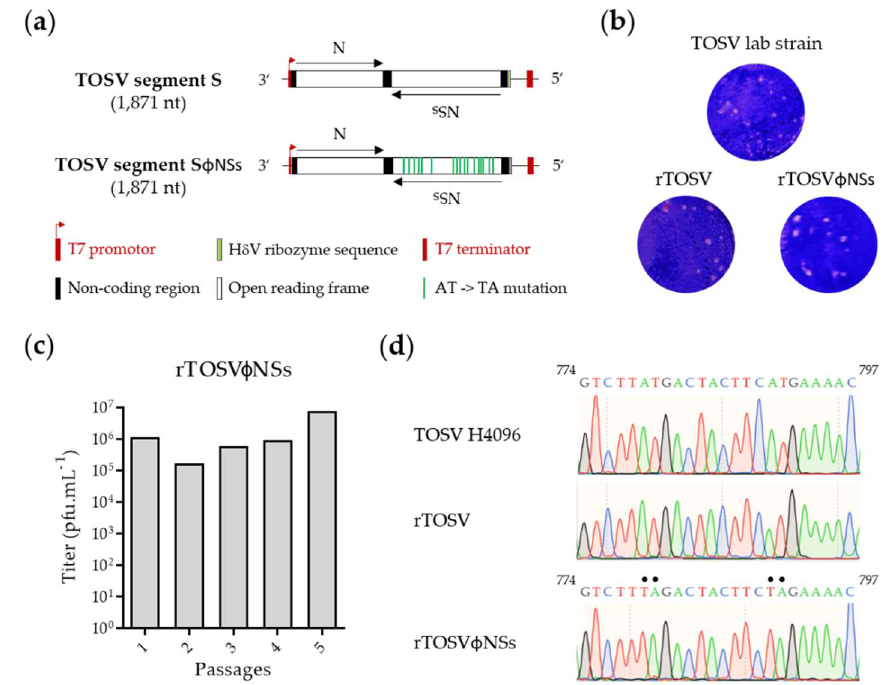
Figure 4. Recovery of rTOSV lacking NSs expression (rTOSV ɸ NSs). ( a ) Schematic representation of a rTOSV S segment encoding NSs mRNA, in which 18 AUG codons are replaced by UAG stop codons. The green bars indicate the mutations in the S segment of rTOSV ɸ NSs; ( b ) TOSV and rescued TOSV +/- NSs expression (rTOSV and rTOSV ɸ NSs, respectively) were analyzed by plaque-forming unit assay on Vero cells five days post-infection; ( c ) Titration of rTOSV ɸ NSs after rescue from cDNAs and